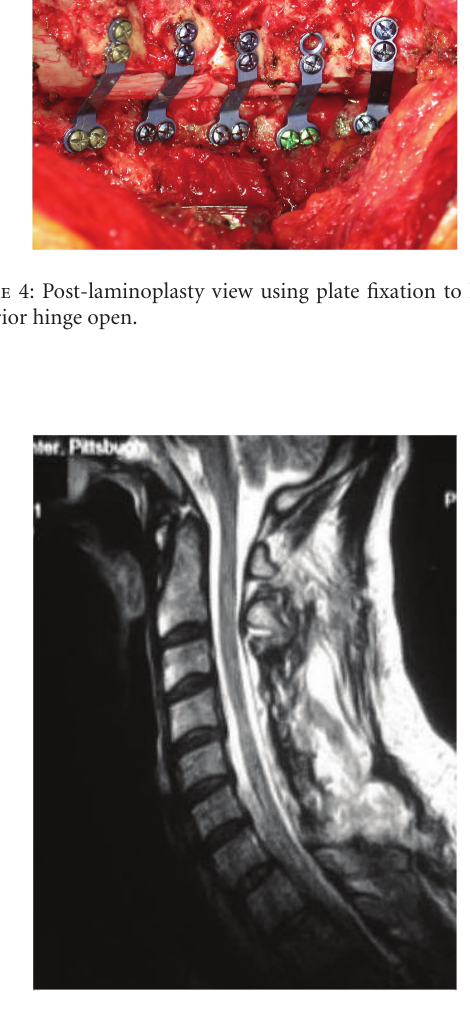
Figure 5: Post-laminoplasty MRI showing the space available for the cord created by the posterior decompression.